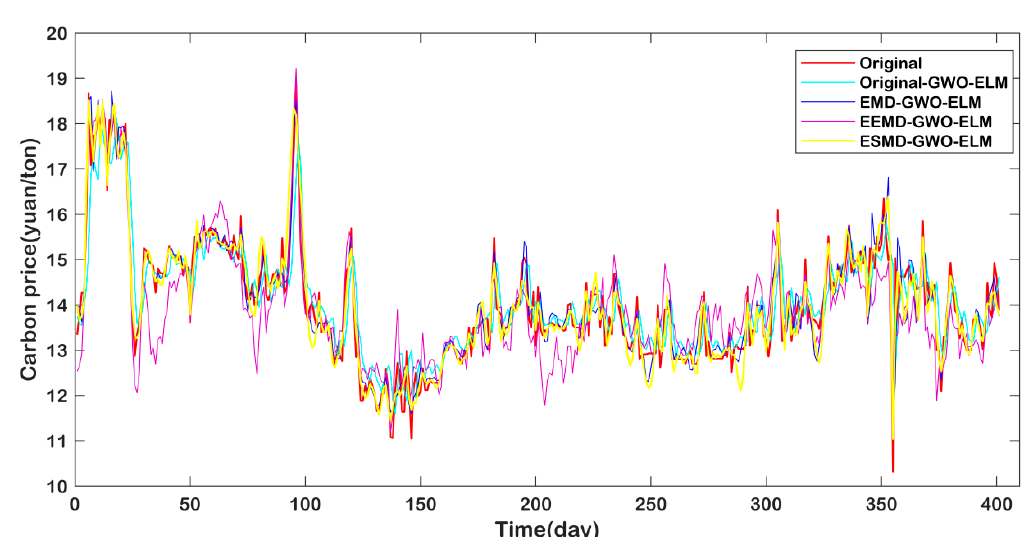
Figure 16. The results of Guangdong carbon price forecasting.